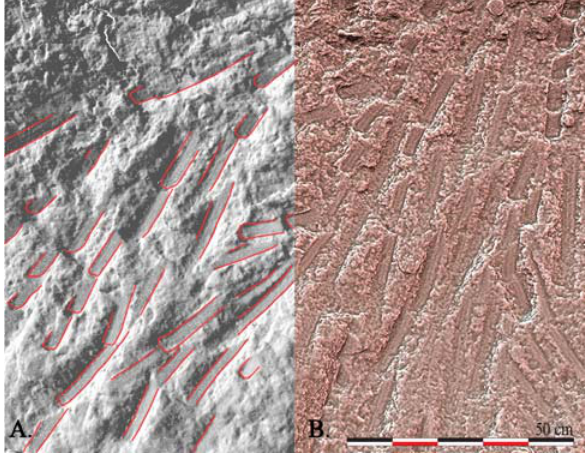
Figure 11. Manually mapped tool marks on surface without texture (A.) and Meshlab’s radiance scaling lit sphere operator to emphasis tool marks (B.)